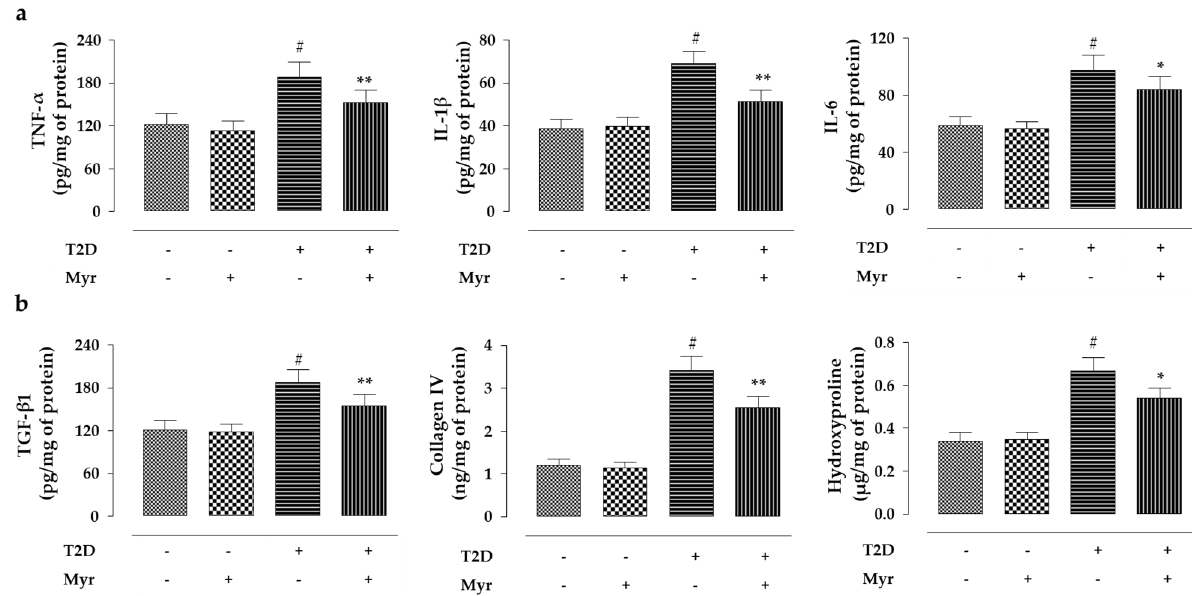
Figure 11. The effects of Myr on renal inflammation and fibrosis in T2D rats. ( a ) The graphs showing the effects on TNF- α , IL-1 β , and IL-6. ( b ) The graphs showing the effects on TGF- β 1, collagen IV, and hydroxyproline. Data are expressed as mean ± SD ( n = 6). # Values significantly ( p < 0.01) differed from the normal control (T2D − ) group. * Values significantly ( p < 0.05) differed from the diabetic control (T2D+) group. ** Values significantly ( p < 0.01) differed from the diabetic control (T2D+) group.